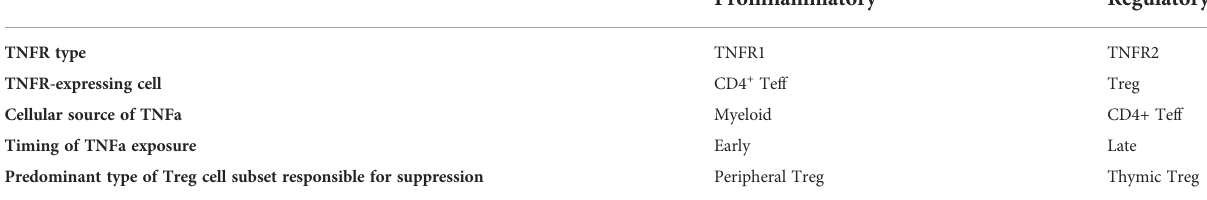
Proin fl ammatory Regulatory